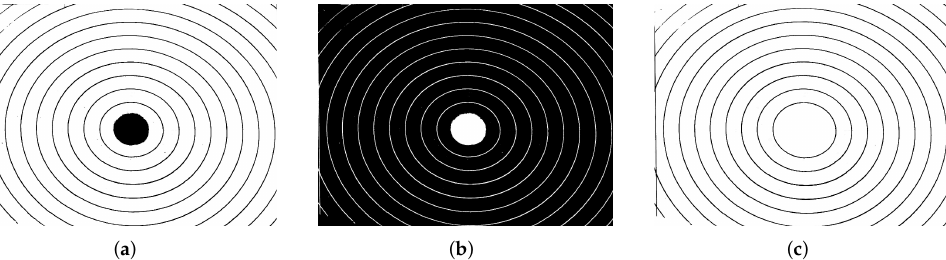
Figure 6. Segmented image. ( a ) Resulting image after the thresholding process. This image is denoted as I b , ( b ) inverted binary image I b (cid:48) , ( c ) this image is obtained after extract the first circle by applying next operator I b (cid:83) J 0